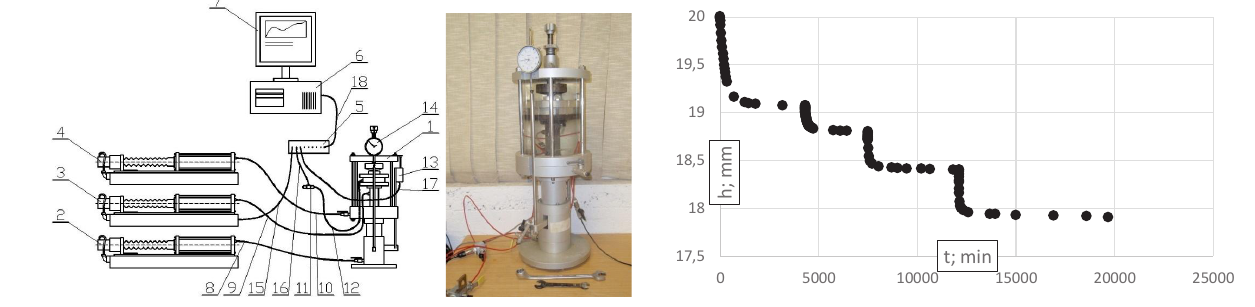
Figure 4. Components of the measuring station and connection of devices (description in text).